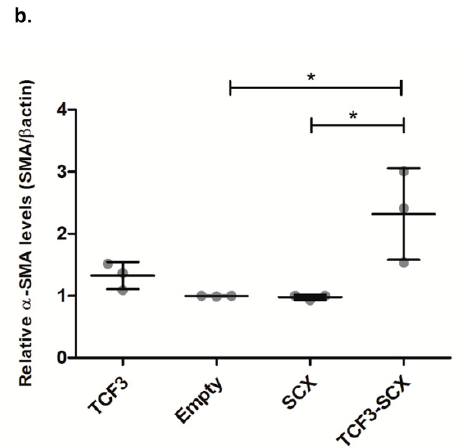
Figure 8. SCX overexpression promoted an induction in α -SMA expression that was dependent on TCF3. ( a ) The expression of the indicated proteins was analyzed using immunoblots. CCD8Lu cells were transduced with adenoviral vectors for 48 h. The infective particles included an empty vector as a control, and adenoviral vectors encoding SCX, TCF3, and a combination of SCX and TCF3. ( b ) Densitometric analyses of α -SMA induction relative to β -actin, quantifying three independent samples of each transduction. A one-way ANOVA test confirmed statistical differences in α -SMA expression in empty vs. TCF3-SCX samples. * p = 0.0086.